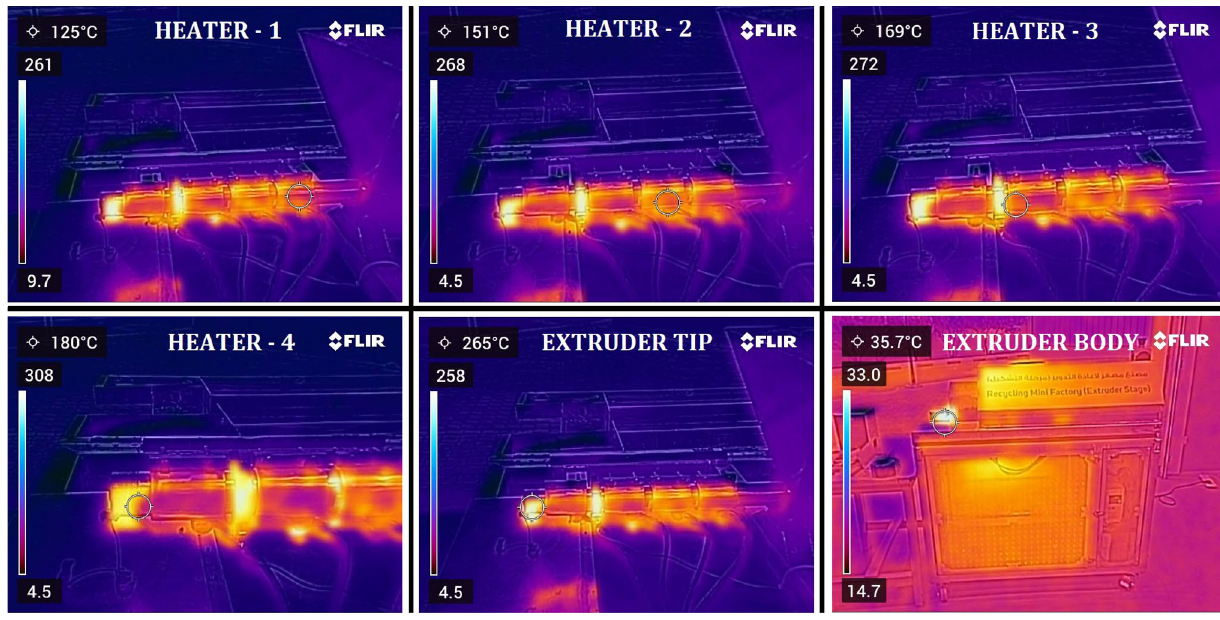
Fig. 17 Reaching the melting point of plastic with four